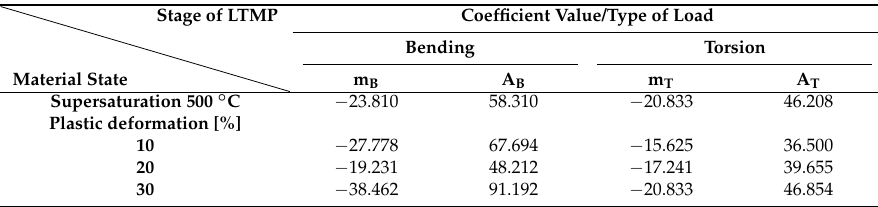
Table 3. Equation coefficients of regression lines for AlZn6Mg0.8Zr alloy after various stages of low-temperature thermomechanical processing (LTMP) and cyclic load tests.